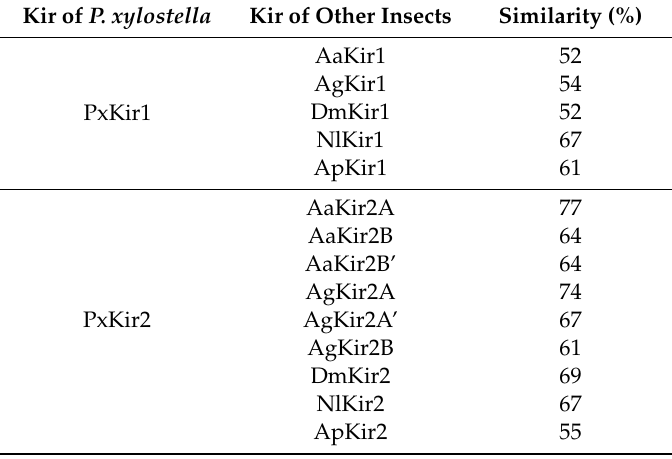
Table A2. Amino acid sequence similarity of Kirs between Plutella xylostella and other